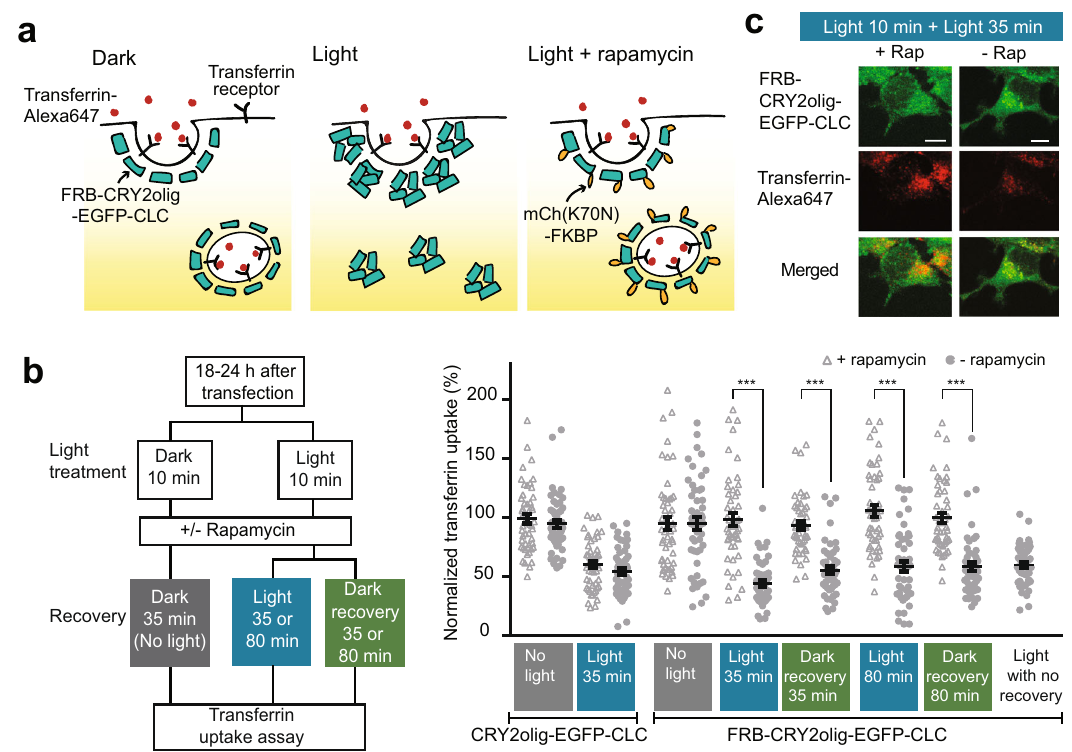
Fig. 6 Use of DisCo to rapidly reverse endocytosis blockage induced by CRY2olig and light. a Schematic showing use of DisCo to reverse light- dependent blockage of clathrin-mediated endocytosis induced by CRY2olig clustering. b Timecourse (left) and results (right) of endocytosis assay. CRY2olig-clathrin light chain (CLC) constructs with or without a FRB hook were coexpressed in HEK293T cells along with mCh(K70N)-FKBP as C-BLOCK. 18 – 24 after transfection, cells were kept in dark ( ‘ No Light ’ ) or exposed to blue light (465 nm, 1 s pulse every 30 s for 10 min). Cells were treated with 333 nM rapamycin or vehicle, then incubated for 35 or 80 additional minutes in light (465 nm,1 s pulse every 30 s) ( “ Light ” ) or dark ( “ Dark recovery ” ) as indicated, then assayed for transferrin uptake. As a control for the reduction of transferrin uptake due to light treatment, cells were treated with light (465 nm, 1 s pulse every 30 s for 10 min) and assayed for transferrin uptake immediately after the light treatment (Light with no recovery). Transferrin uptake is expressed as a percent of results obtained from neighboring untransfected cells (set at 100%). Data represents average and error (s.e.m., n = 50 cells). Parametric t-test (two-tailed) between + /- rapamycin-treated cells showed a signi fi cant difference (***) with p < 0.0001 (Light 35 min, p = 1.4 ×10 − 14 ; Dark recovery 35 min, p = 1.4×10 − 14 ; Light 80 min, p = 1.7×10 − 10 ; Dark recovery 80 min, p = 5.5 ×10 − 11 ).The experiment was performed an additional time with similar results. c Representative images of transferrin uptake in experiment shown in ( b ). Cells treated with DisCo ( “ + Rap ” ) show recovery from CRY2olig-CLC clustering and normal uptake of transferrin even when incubated in light. The experiment was performed an additional time with similar results. Scale bars, 10 µ